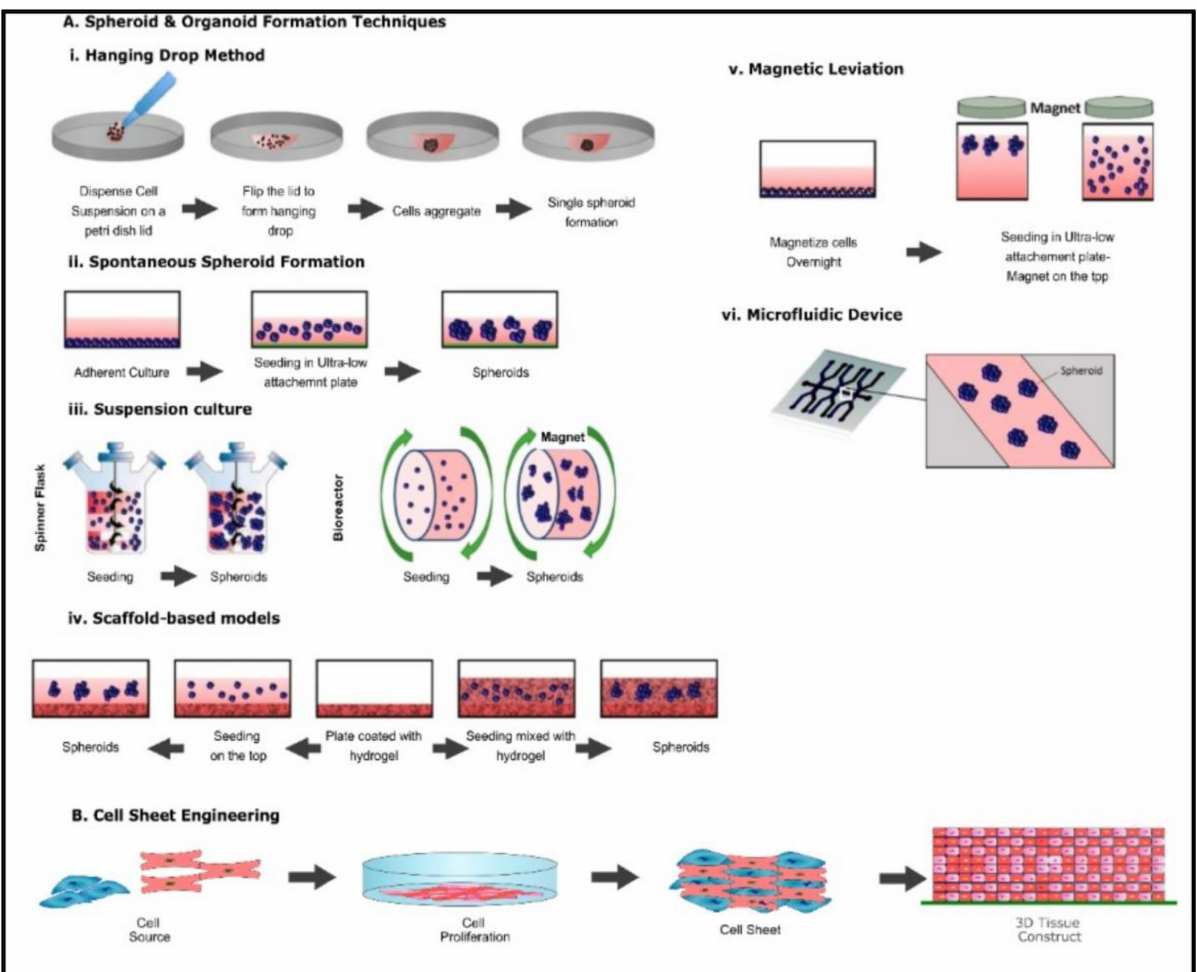
Figure 2. Common fabrication techniques used for the creation of spheroids, organoids, and cell sheet ( A ) (i) Hanging drop method (ii) Spontaneous spheroid formation (iii) suspension culture (iv) ECM method (v) Magnetic levitation method, (vi) Microfluidic device method. Altered and reproduced with permission from [27] under Open Access CC BY 4.0. MDPI ( B ) Schematic representation of cell sheet